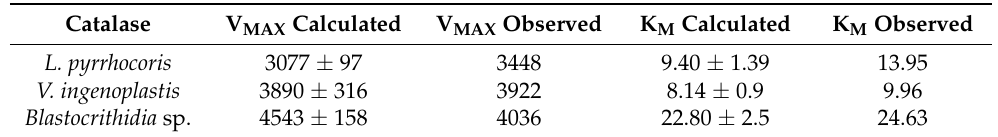
Table 1. Observed and calculated by non-linear regression analysis V MAX and K M values of try- panosomatid catalases expressed (in µ M/min and mM,